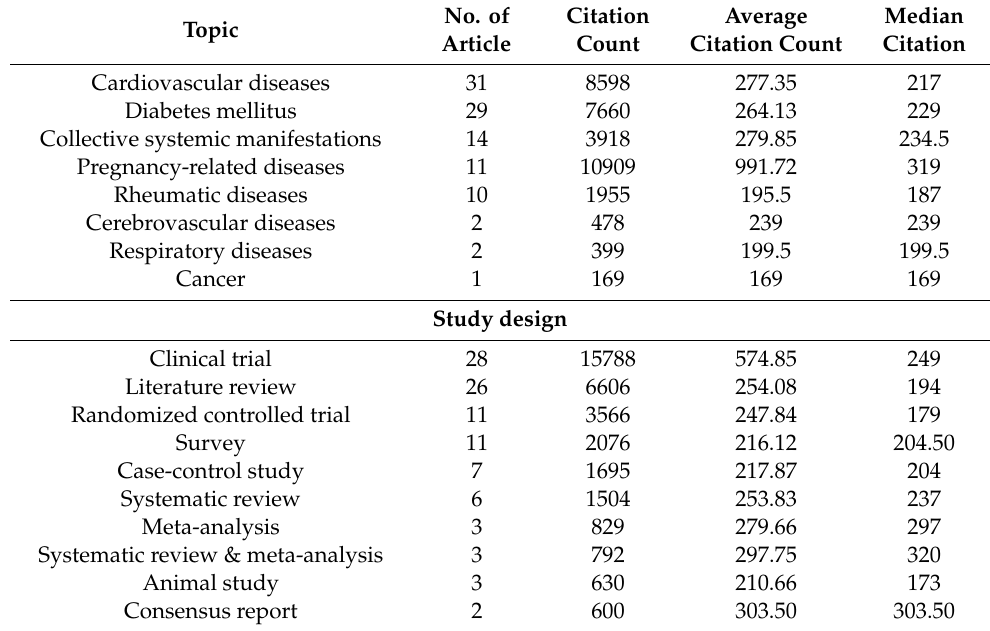
Table 3. Distribution of topics and methodological designs of the 100 most-cited articles.